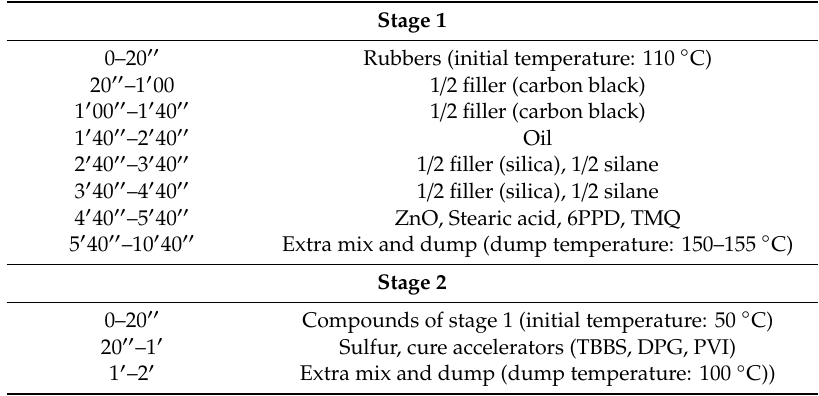
Table 2. Compounding procedure for the styrene butadiene rubber (SBR) binary filler